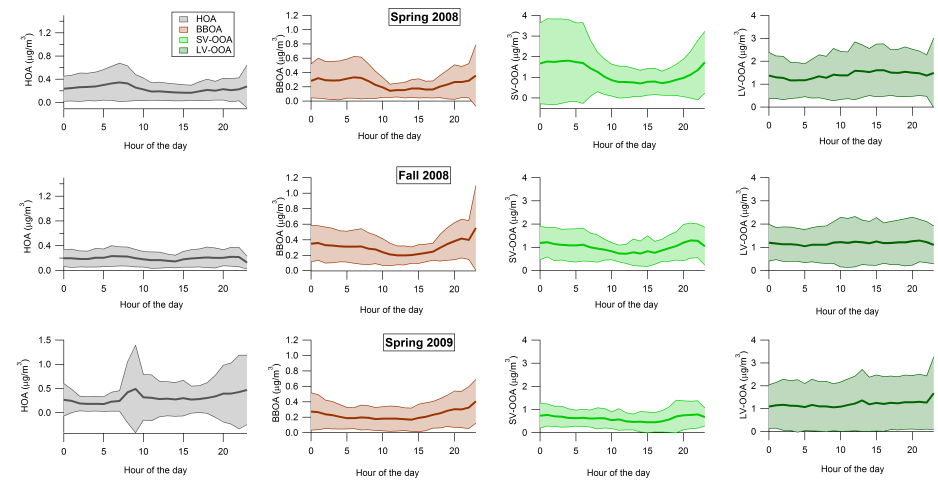
Figure 6. Diurnal profiles of organic aerosol components. Mean values ( ± standard deviation) for OA components are shown for the different seasons and all